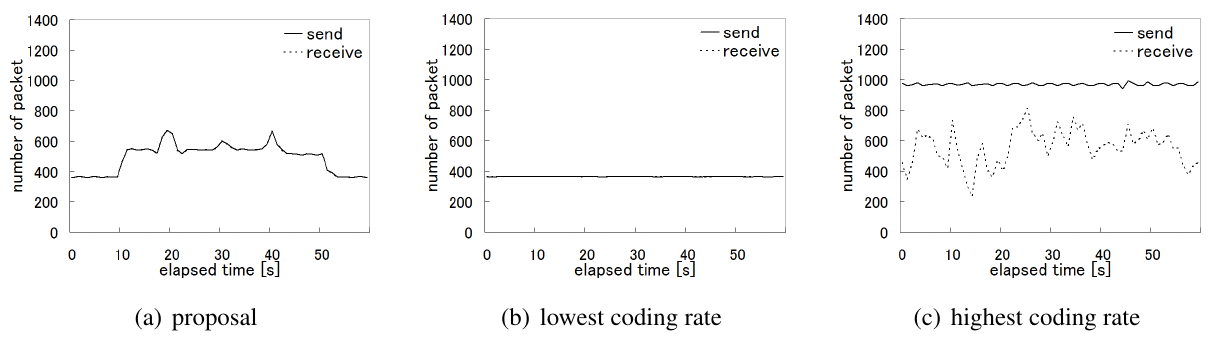
Figure 18 . The total number of sent and received